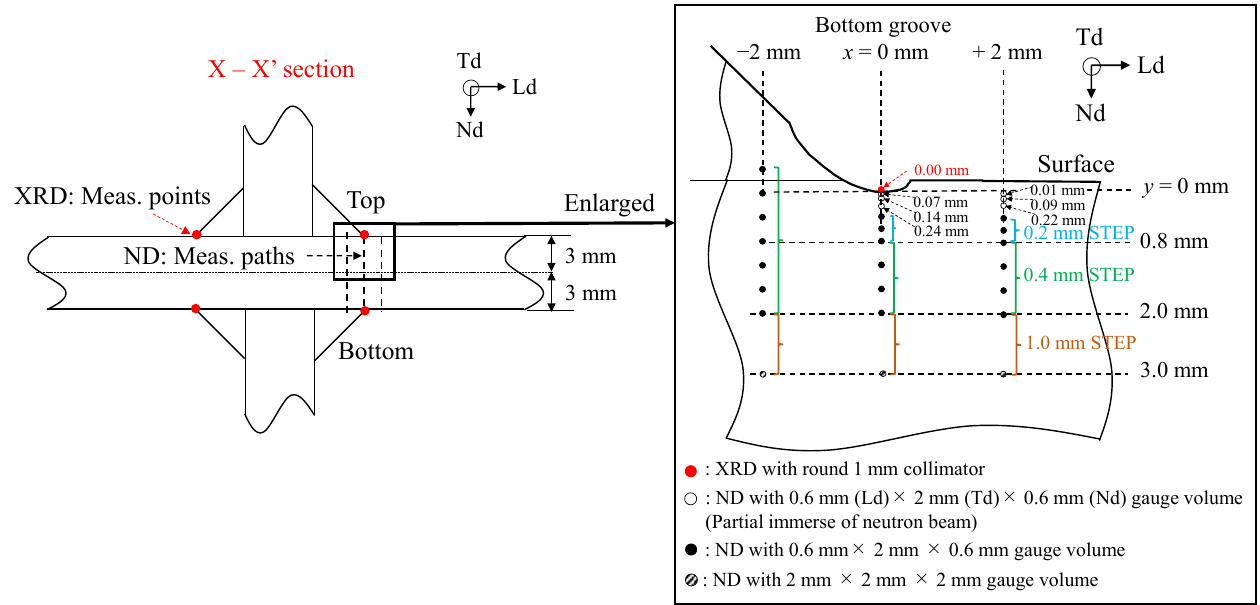
Figure 3. Measurement points and paths through the thickness for XRD and ND methods.